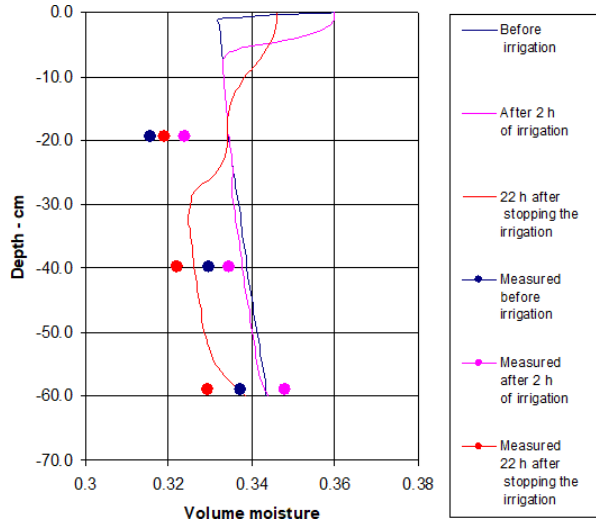
Figure 13. Comparison of volumetric moisture values measured in a study section with computerized values in the model. Model cali- bration results.